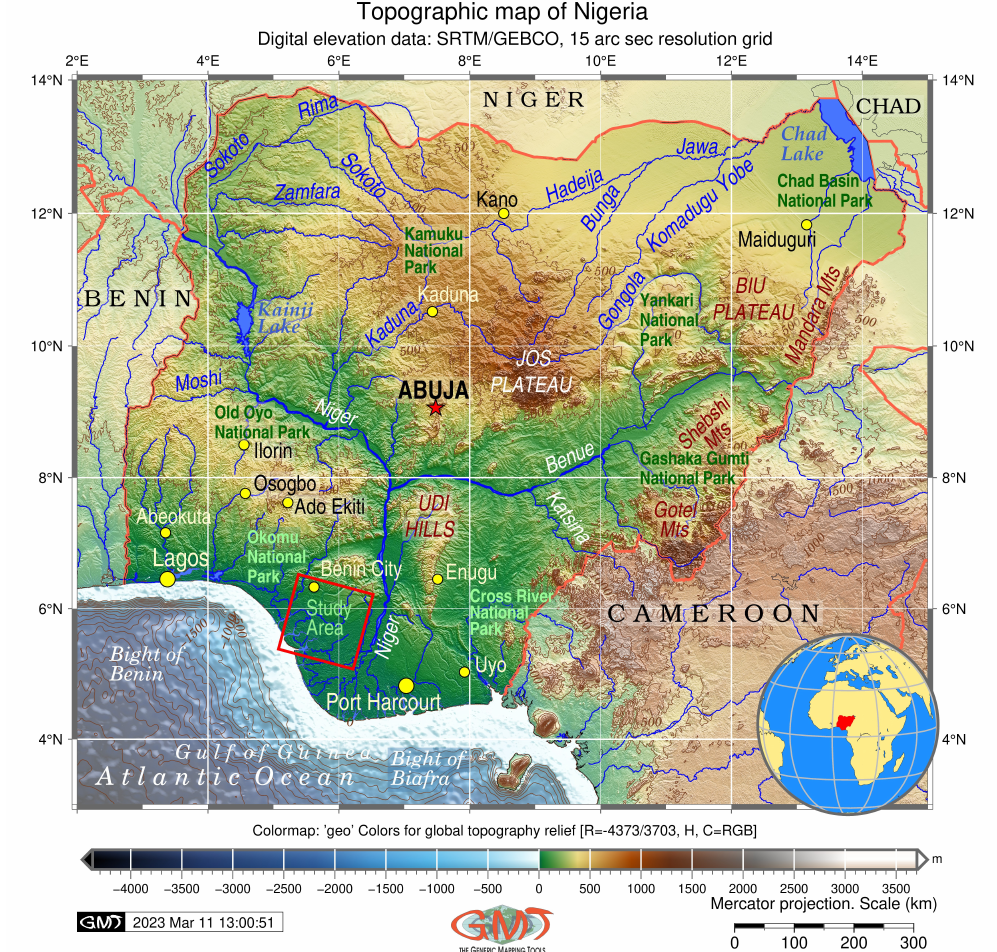
Figure 1. Topographic map of Nigeria with indicated study area. Yellow dots indicate cities, red pentagram indicates a capital. Software: Generic Mapping Tools (GMT) version 6.1.1, ref. [42]. Data source: GEBCO/SRTM [43,44]. Cartography source: